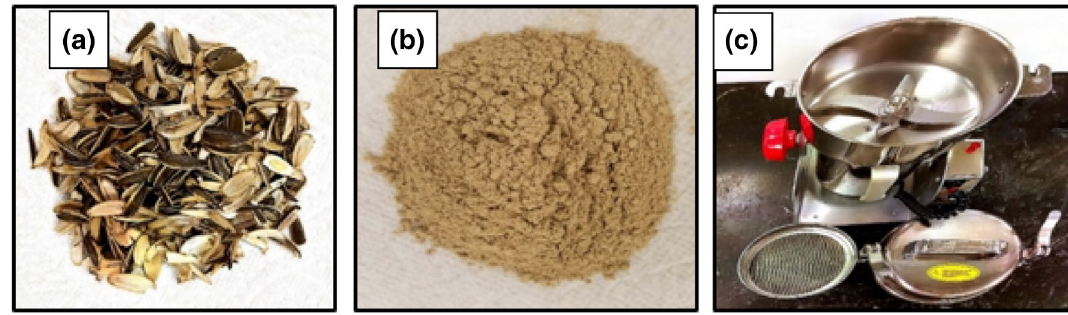
Fig. 1 a The raw waste of black sunflower shells (BSS), b the black sunflower shells’ powder (BSSSP), and c the food